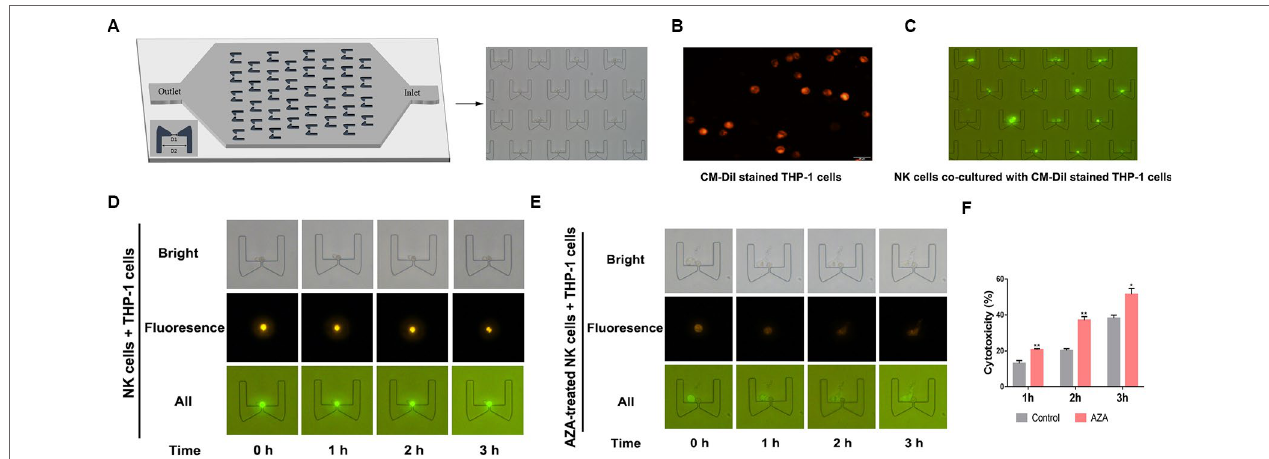
FIgUrE 4 | Azelaic acid (AZA) enhanced the cytotoxicity of NK cells against acute myeloid leukemia (AML) cells. (A) The micro-fluidic chips used for trapping cells and cytotoxic analysis, D1 = 5 μm and D2 = 50 μm. The NK cells and the target cells can be trapped from two opposite directions between the clips. (B) The CM-Dil stained THP-1 cells membrane can display an orange-red color with the excitement of green light. (c) The fluorescent THP-1 cells (CM-Dil stained) and NK cells (none stained) were trapped in the micro-fluidic chip and observed with a fluorescence microscope. (D , E) NK cells and AZA-treated NK cells were in contact with trapped THP-1 cells. The THP-1 cell motion morphology was observed on the micro-fluidics chip with a fluorescence microscope. (F) The total number of CM-Dil stained membrane rupture cells in different fields at different times were observed under the microscope. Data represent standard deviations for three independent experiments. Statistical significance was determined with student's test. *P < 0.05, **P < 0.01.